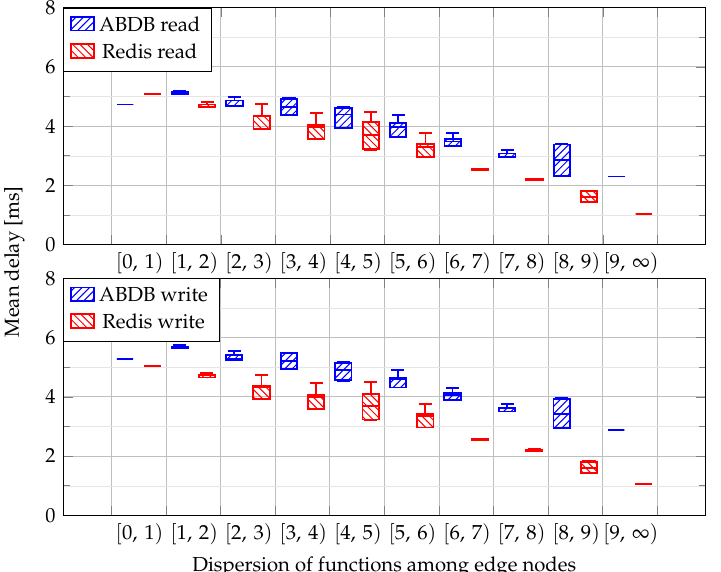
1.87 ms in write delay at the highest dispersion.